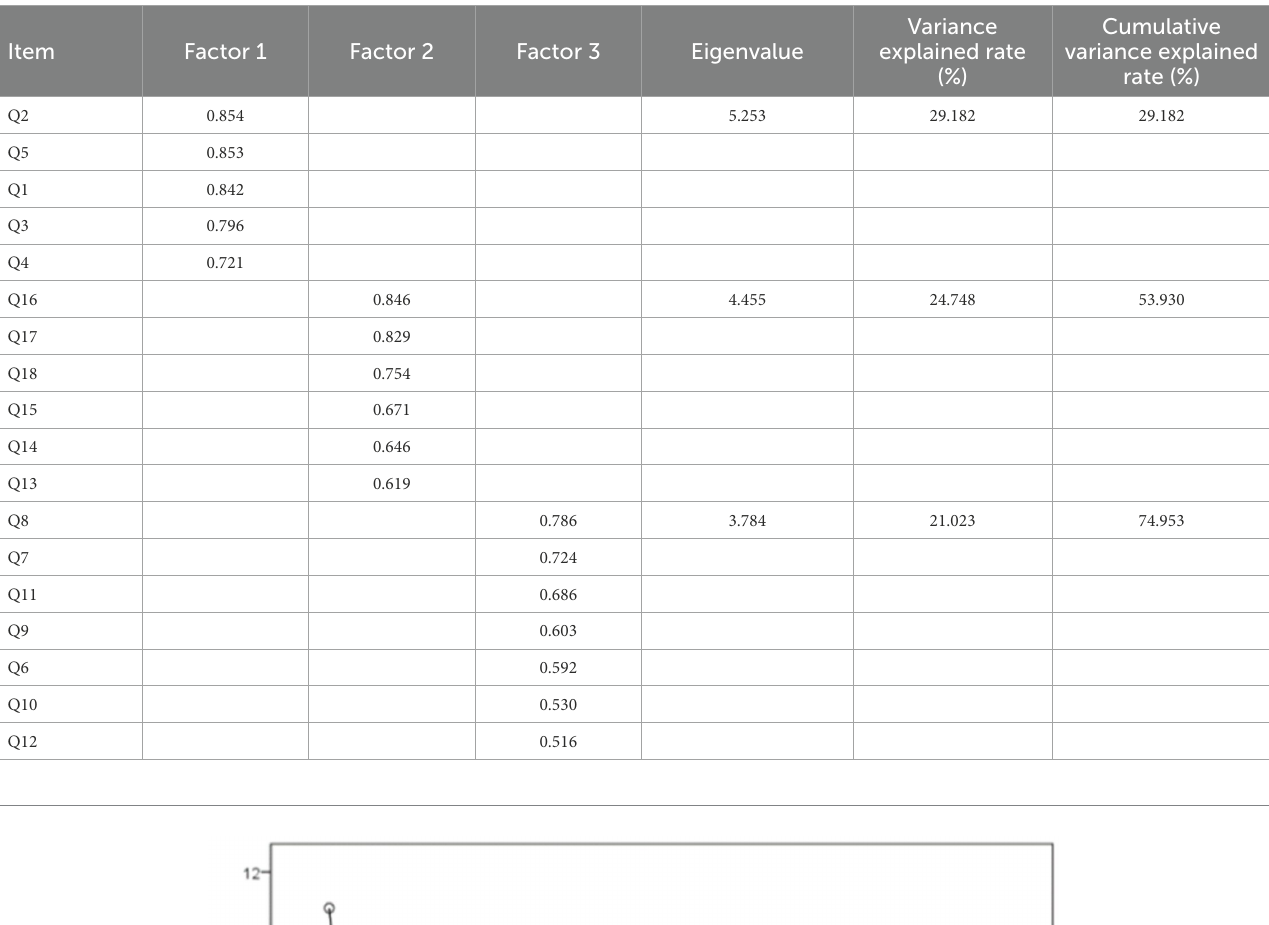
TABLE 2 Loading factor of technical morality factor.